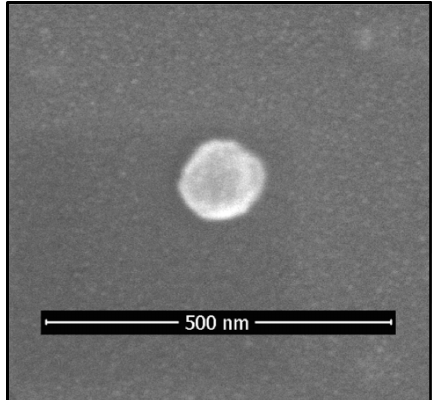
Figure 7. SEM image of a single TiO 2 particle magnified 80000 × used within this